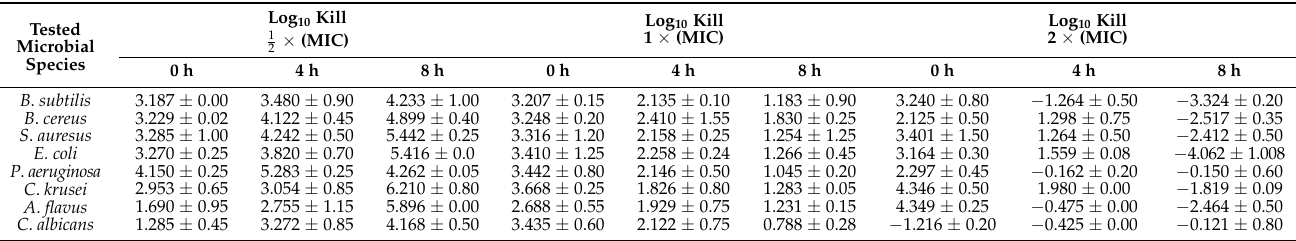
Table 6. In vitro time kill assay of native extract of H . griffithi .